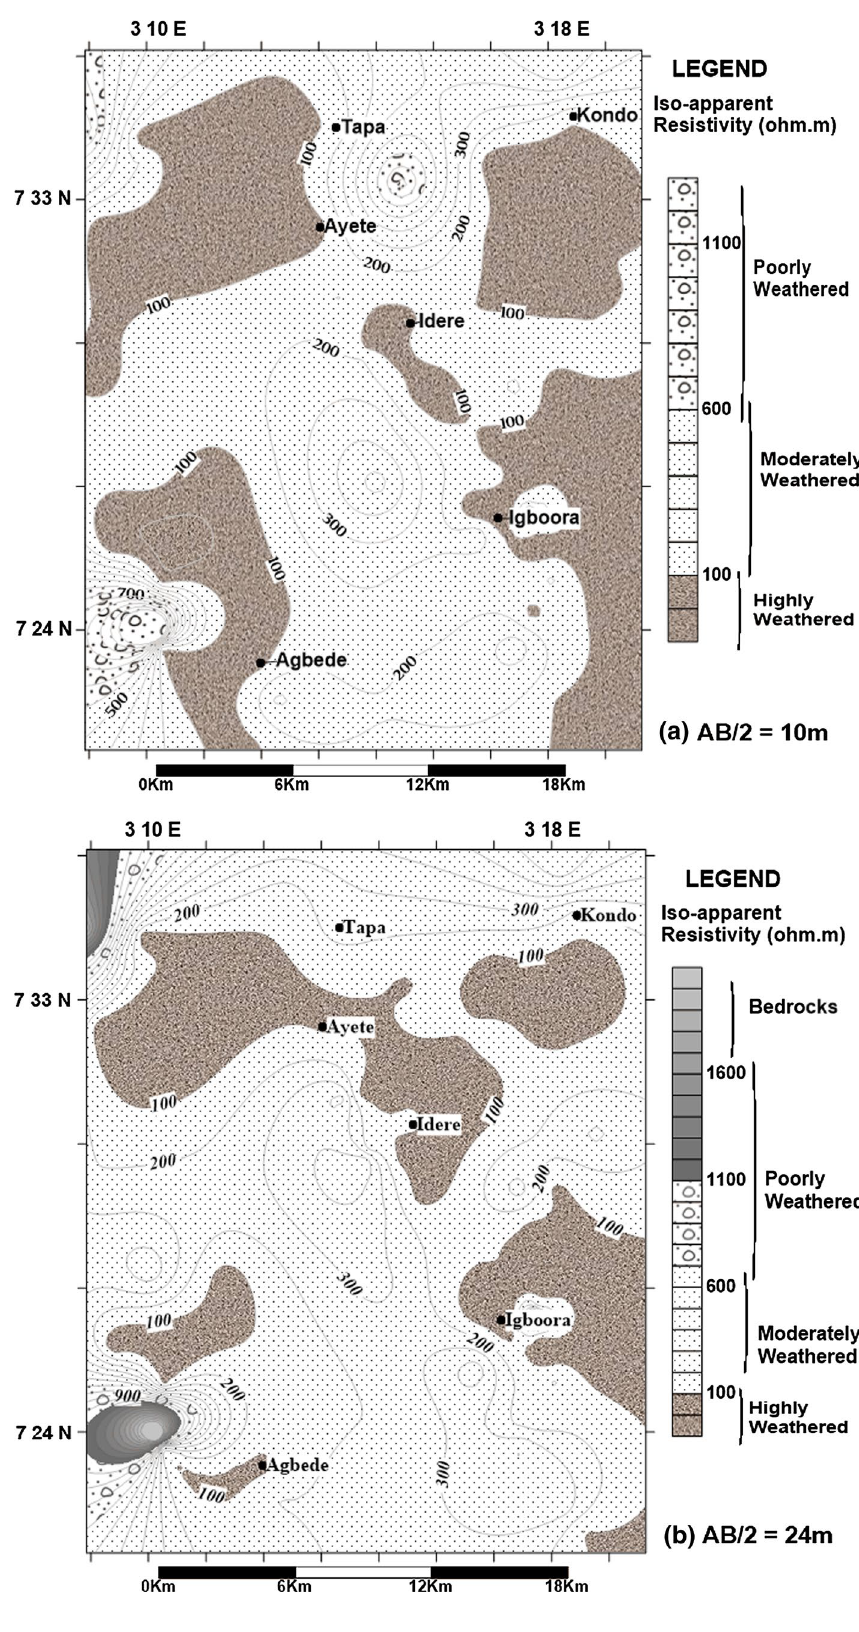
Fig. 5 Indication of weathering development at corresponding depths to half AB